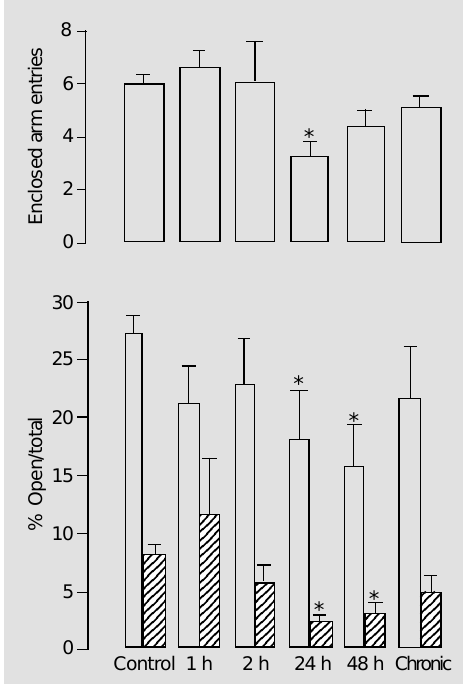
Figure 1 - Elevated plus-maze ex- ploration by rats (N = 11-16) 1, 2, 24 or 48 h after a 2-h restraint period, as compared to non- stressed animals (Control, N = 65). A further group (Chronic) was tested 24 h after seven con- secutive daily periods of 2-h re- straint (N = 16). The upper panel shows the mean (± SEM) num- ber of entries into enclosed arms. The lower panel shows the mean (± SEM) percentage of entries (open bars) and time spent (hatched bars) in the open arms. *P<0.05 compared to con- trol (ANOVA followed by Duncan